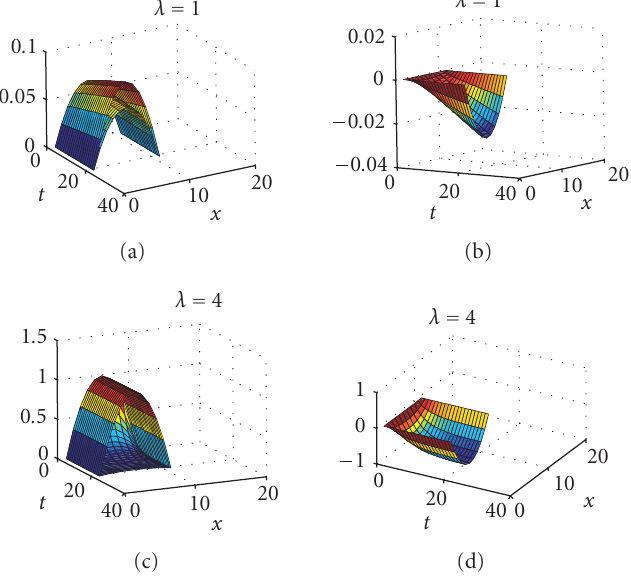
Figure 4.5. The upper solutions u ( x , t ) and v ( x , t ) and the di ff erence v ( x , t ) − u ( x , t ) for the slab ge- ometry, when β = 0 . 5, δ = 0 . 1, and λ =